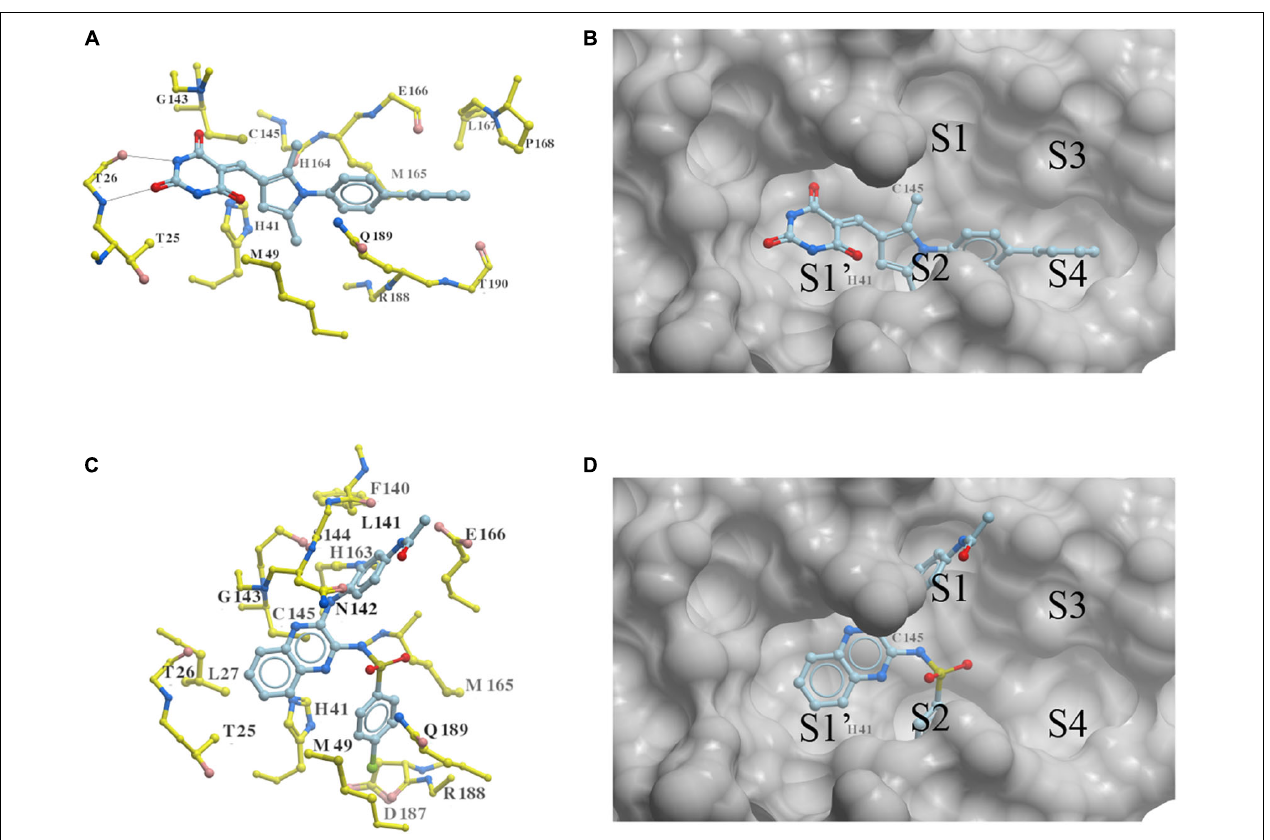
FIGURE 4 | Docking conformations of newly identified 3CLpro SARS - CoV - 2 inhibitors: (A,B) PMPT; (C,D) CPSQPA. 3CLpro was modified from the 6LU7 structure by removing the ligand and water. Protein is colored in yellow. Compounds are colored in sky blue. Amino acid residues interacting with the ligands are labeled. Surface of the protein is displayed and colored in gray (B,D) . Hydrogen bonds between PMPT and 3CLpro are shown as black lines (A) . As CPSQPA likely has a net charge of -1 (sulfonamide p K a ’s generally are in the range of 5.0–7.0), the anionic form was docked into the protein (C,D) . S1 (cid:48) , S1, S2, S3, and S4 are the sub-pockets for